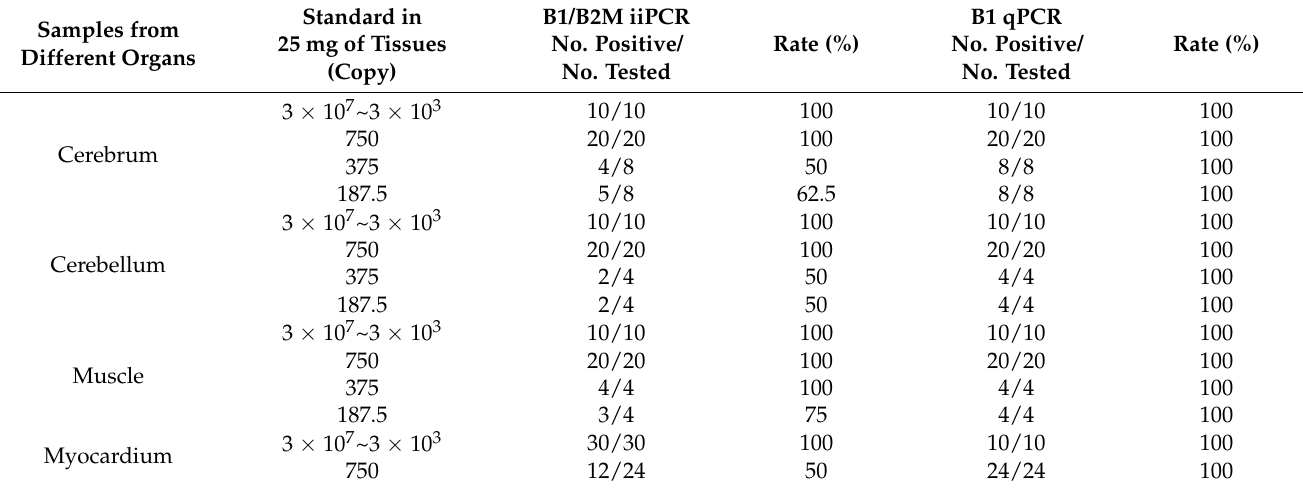
Table 5. Sensitivity in duplex iiPCR.